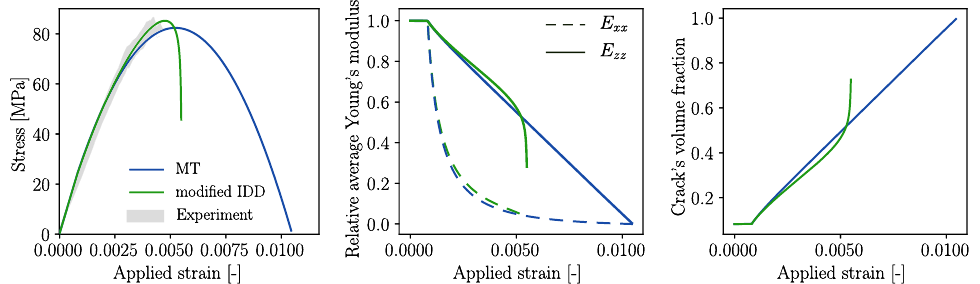
Figure 18. Left: Computed stress–strain response of mortar subjected to uniaxial compression using the calibrated MIDD scheme (green) in comparison with the experimental range (grey) and calibrated Mori–Tanaka scheme (blue). Center: Evolution of stiffnesses in x and z -directions, respectively. Right: Evolution of microcrack volume